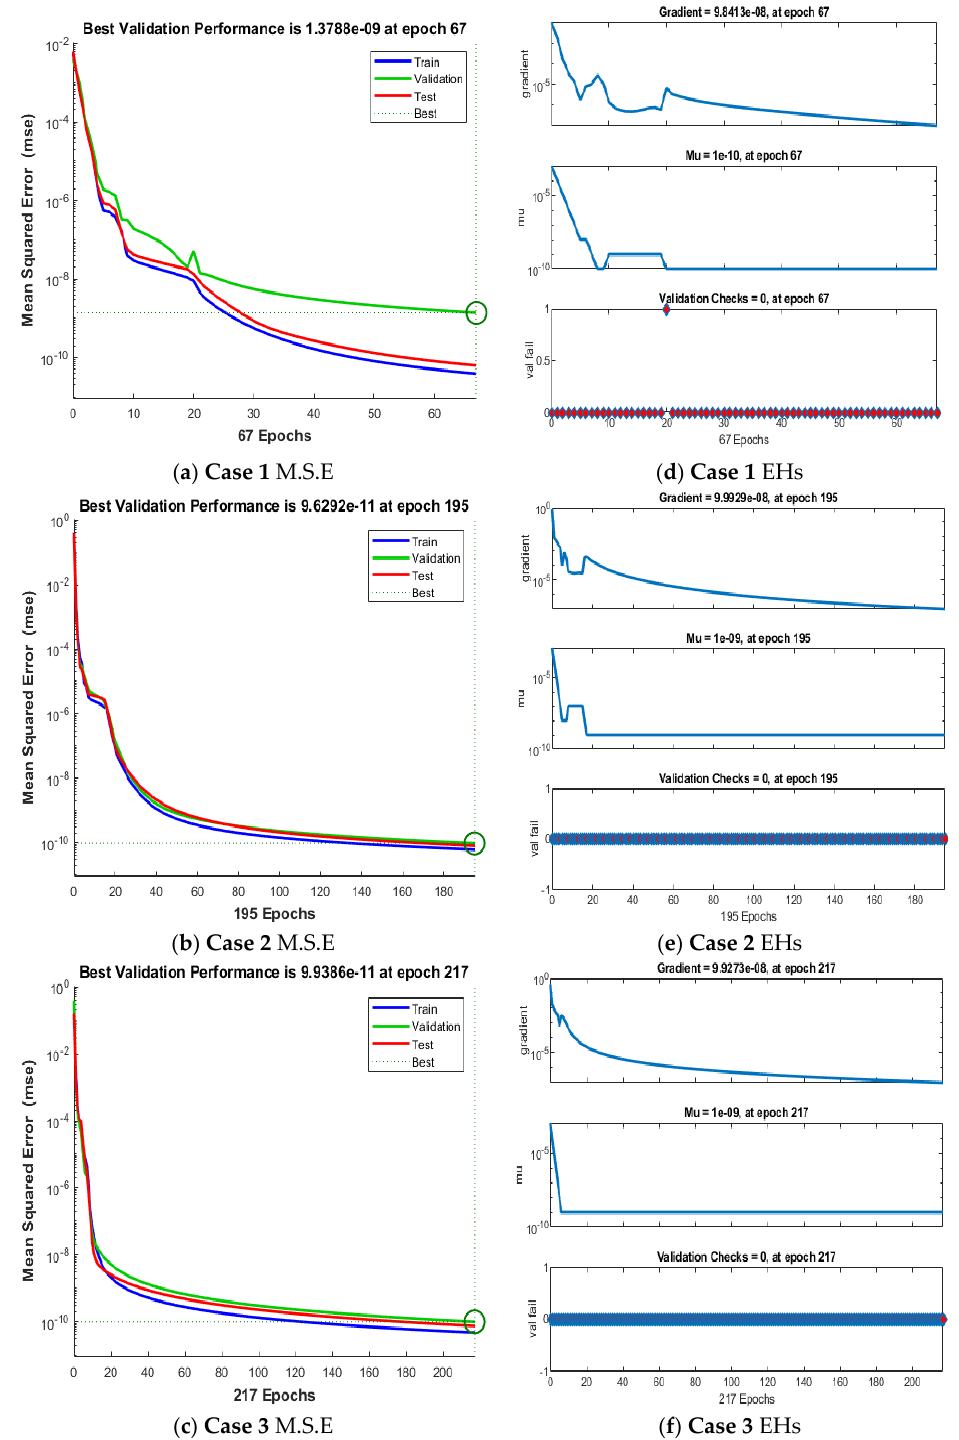
Figure 4. Performances of M.S.E ( a – c ) and State transition ( d – f ) to solve the nonlinear COVID-19 spreading model.